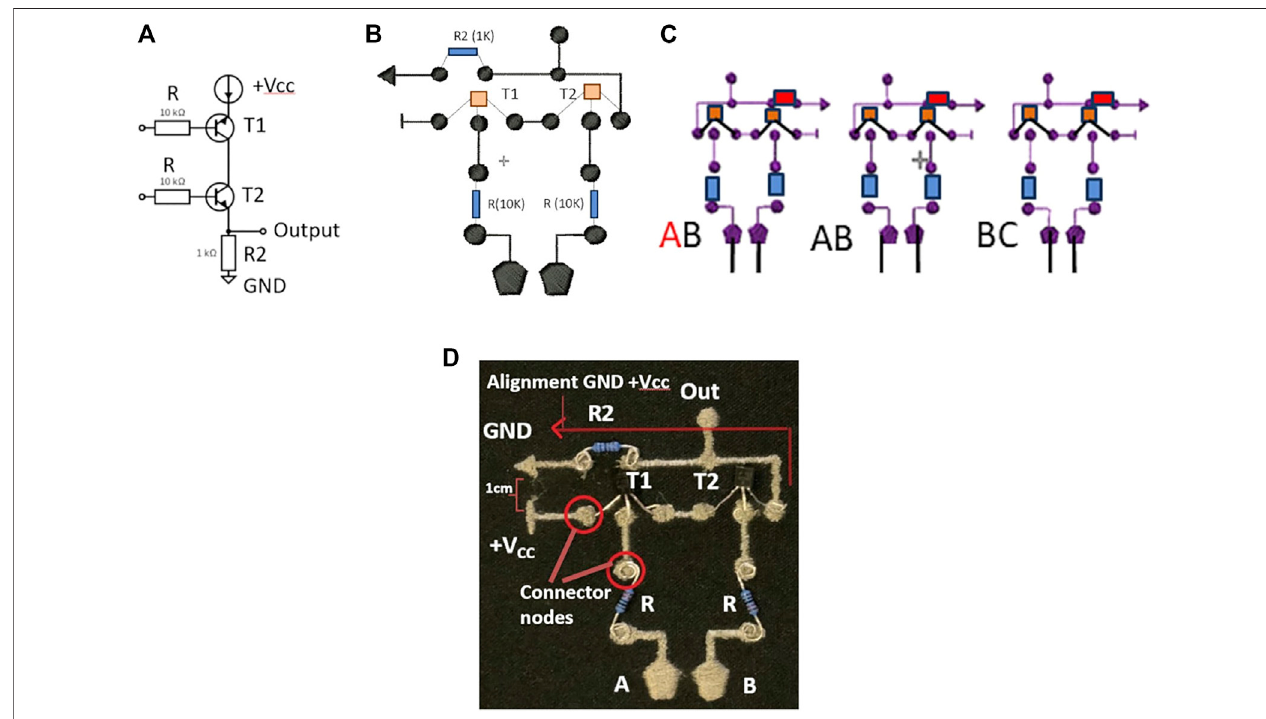
FIGURE2| ANDlogicgate: (A) 2-inputlogicANDgateconstructed usingRTLresistor – transistor, (B) createdembroidereddigitizeddesignfortheANDlogicgate, (C) structure of the AND gate cluster format, and (D) embroidered AND logic gate, detailing connector nodes and the modi fi ed GND conductive connection.